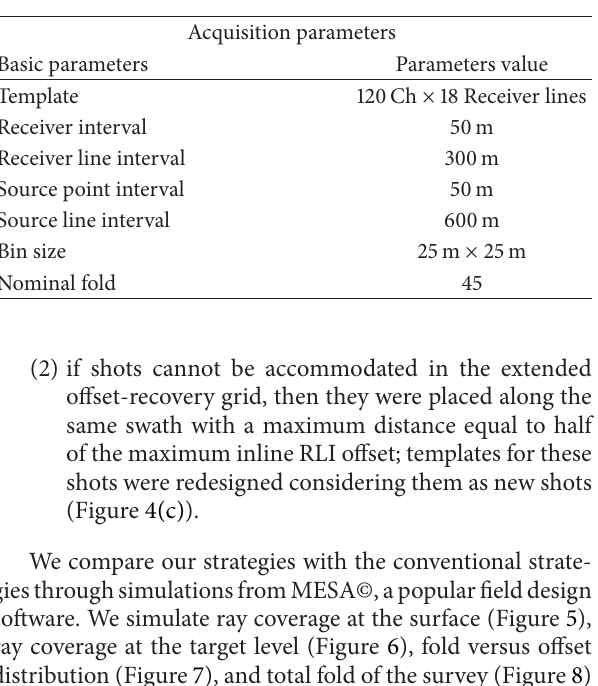
Table 1: Acquisition parameters of the